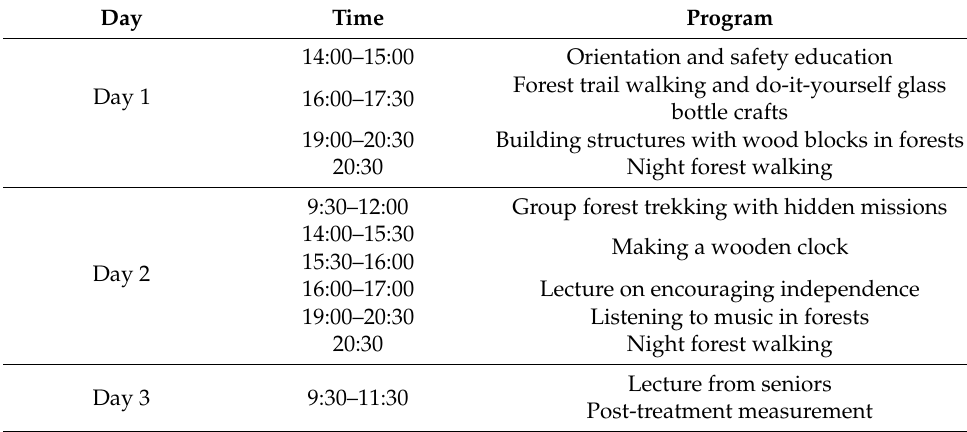
Table 4. Forest healing program schedule.